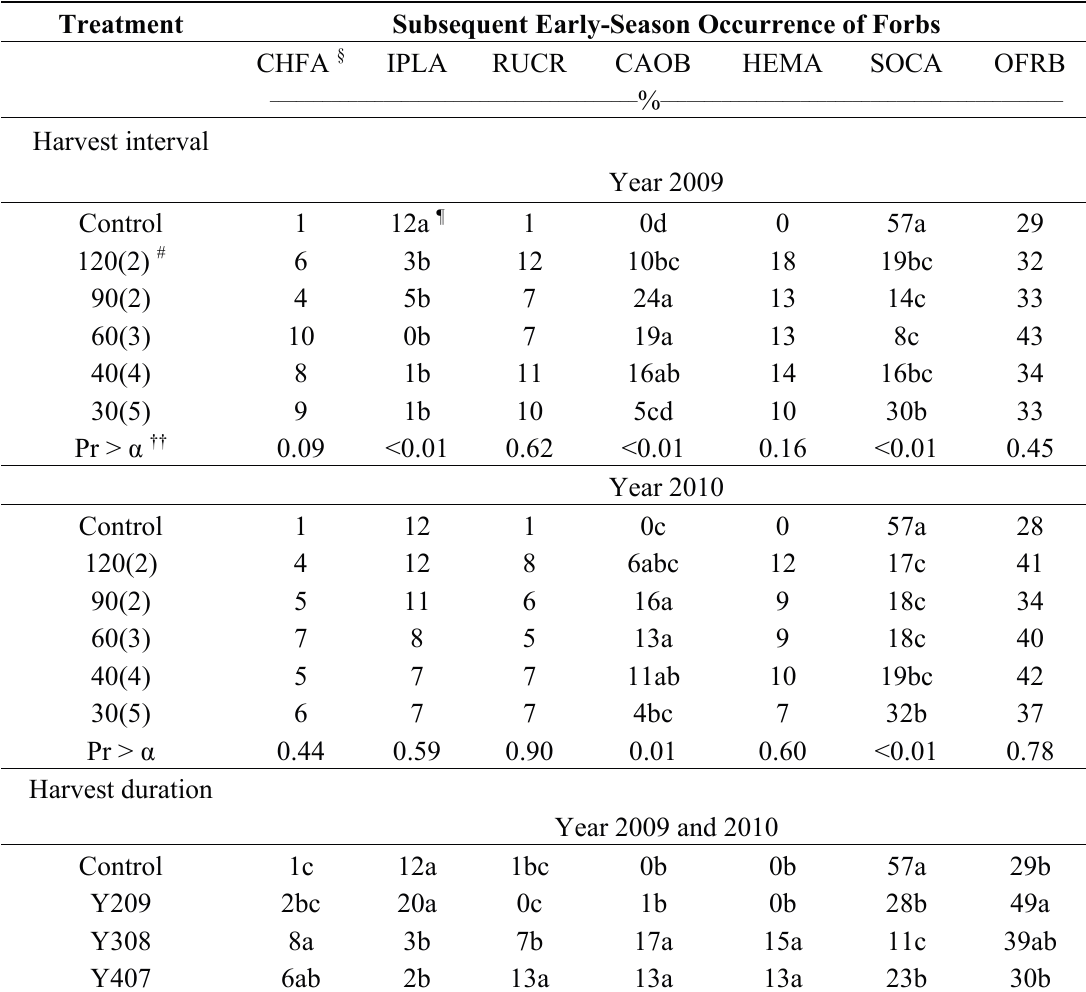
Table 3. Relative distributional response of dominant forbs † to harvest intervals in mixed native warm-season grass stands ‡ , harvested for one or two years, and harvest durations in stands starting (Y2) or ending (Y3) a second harvest year and those rested for a year (Y4), after the last harvest event recorded two weeks after the mid-May harvest in 2009 and